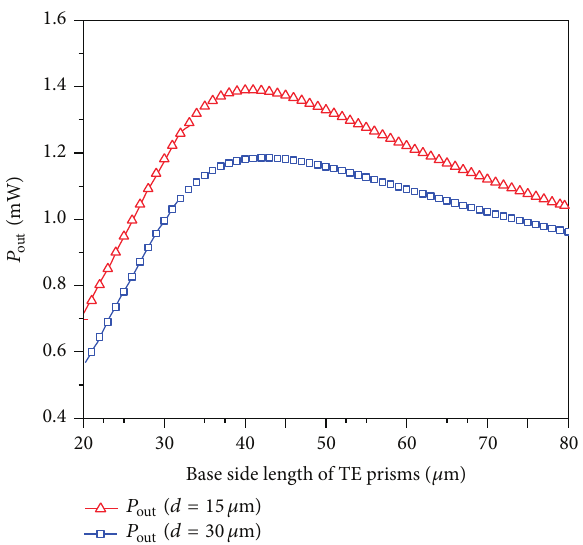
Figure 4: The effects of internal structure parameters ( 𝑎 and 𝑑 ) in the TE modules on the output power of hybrid device.